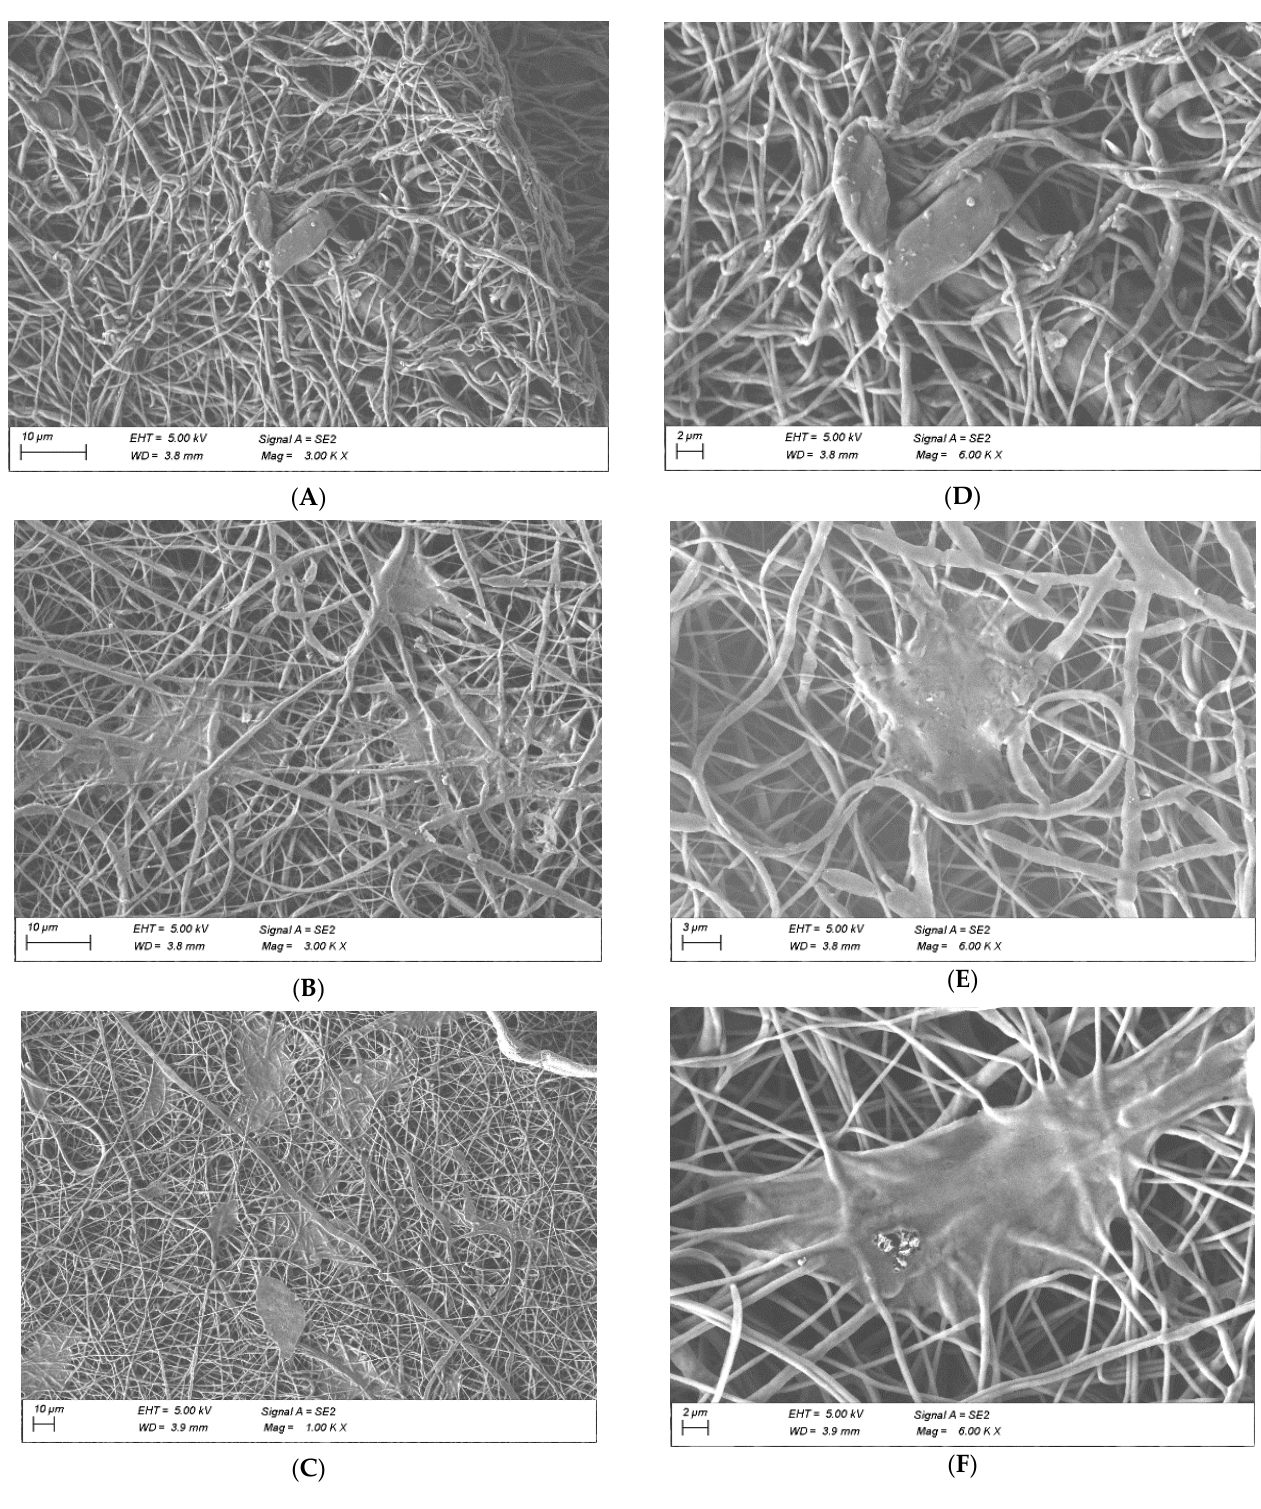
Figure 6. SEM images showing attachment of MEF on the surface of the scaffolds after 72 h: ( A , D ) PCL 10%, ( B , E ) PCL 10% with gelatin coating, ( C , F ) PCL 20%: gelatin 8% (80:20). Scale bar: 10 μ m ( A – C ); 2 μ m ( D – F ).